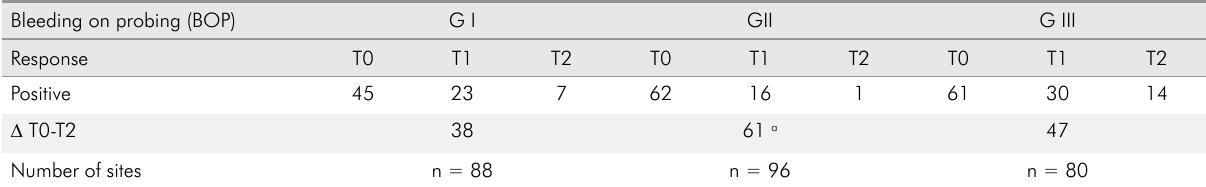
Table 5. Bleeding on probing (BOP) response of the subjects treated with scaling and root planning (SRP) + 10% DOX GEL (GI), 10% DOX/ β -cyclodextrin + SRP GEL (GII) and SRP (GIII), according to values at baseline (T0), 30 days (T1) and 60 days (T2), as well as mean of alterations by sites expressed as